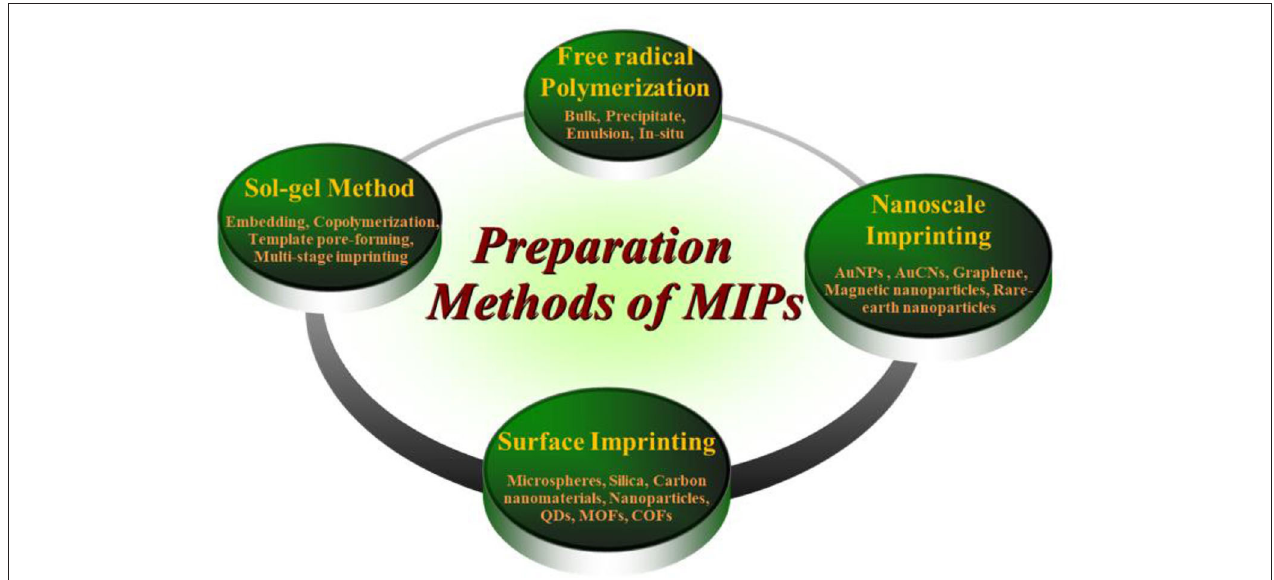
FIGURE 4 | Preparation methods of MIPs based on different polymerizations.